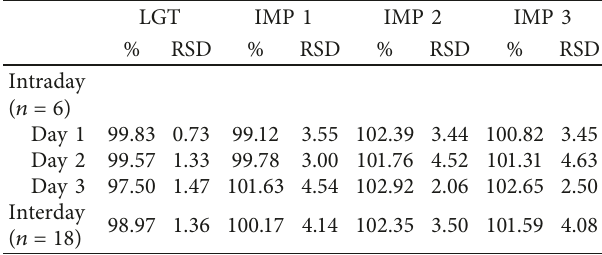
1 ): (a) photodegradation (UVA, 4h); (b) mL · − Table 3: Intraday and interday precision of the analytical